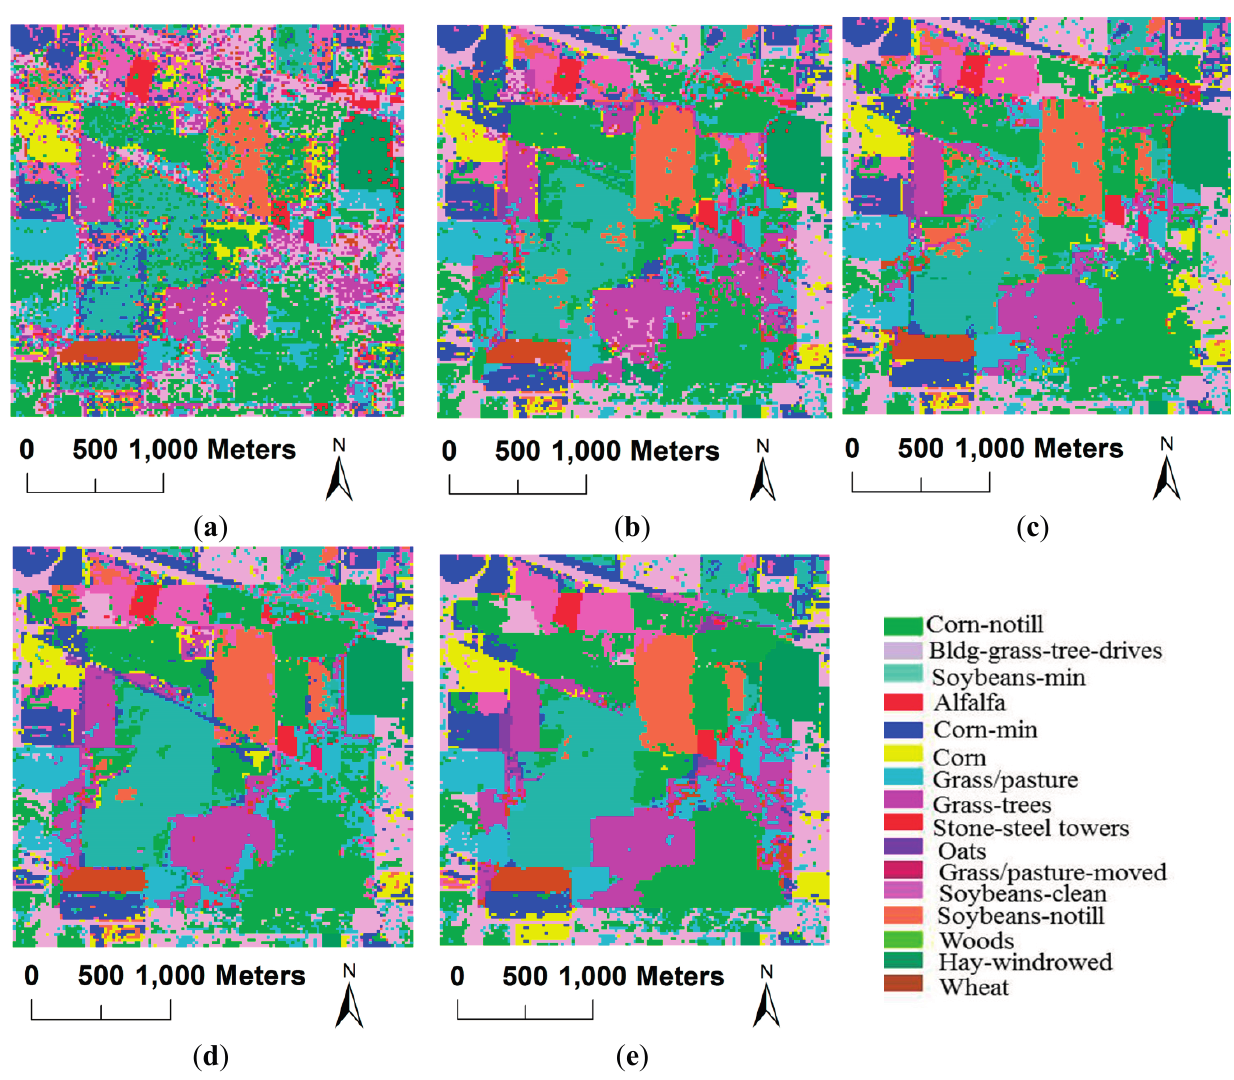
Figure 7. SVM classification results of the AVIRIS Indian Pines by ( a ) the original hyperspectral bands; ( b ) PCA-GLCM with a quantization level of 64; ( c ) K-means GLCM with a quantization level of 64; ( d ) S-GLCM (1) with a quantization level of 64; ( e ) C&S-GLCM with a quantization level of